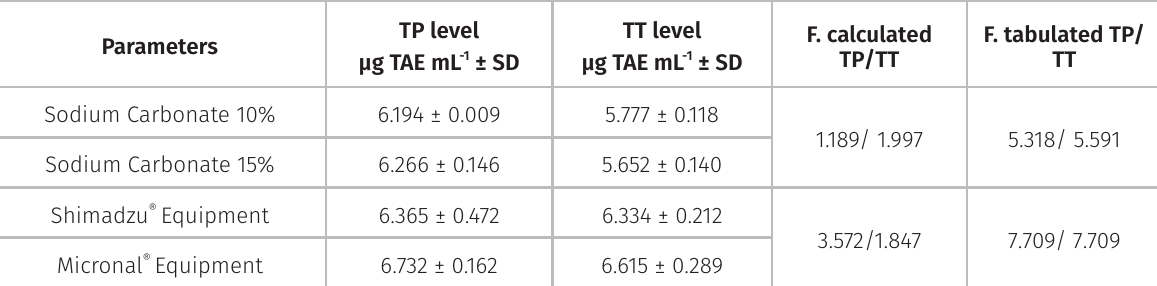
F. calculated TP/TT